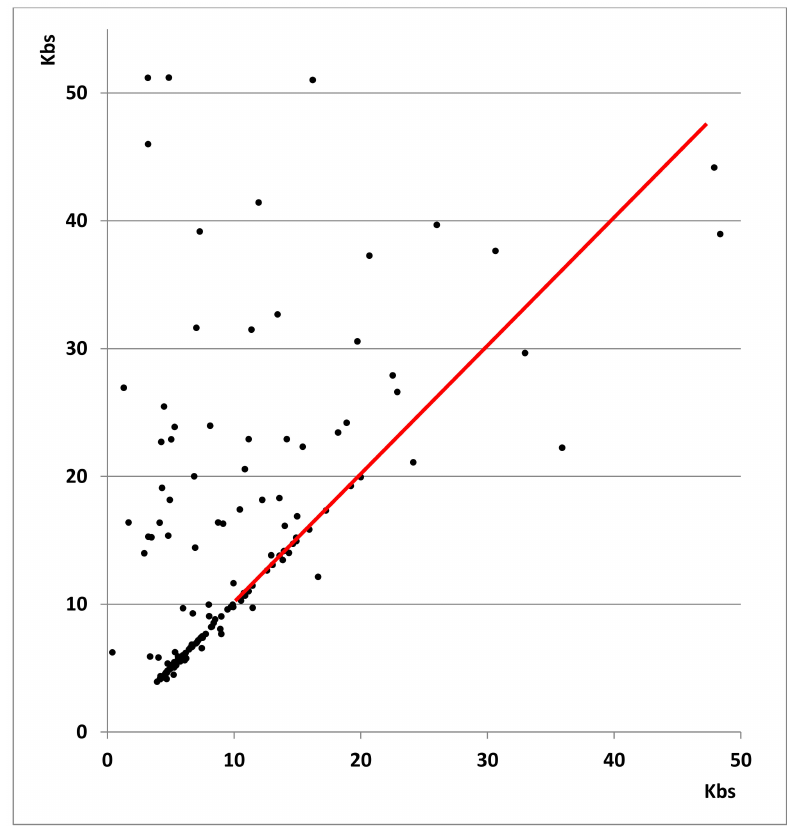
Figure 1. Comparison of satellite lengths in the two new Caenorhabditis elegans genome assemblies. Satellites with an identical repeat found in equivalent genomic regions are compared. The length of satellites over 4 kb in the VC2010 assembly is represented as a function of their length in the LH (PacBio) assembly. The red line indicates an identical length of satellites in both assemblies. Only a few satellites in the VC2010 assembly are shorter than in the LH assembly. In the size range 4–20 kb, 68% of the satellites have an identical size. Lengths are different for all 40 satellites over 20 kb; five of them, over 55 kb, are omitted from the figure. Details for all these satellites are given in Supplementary Datafile